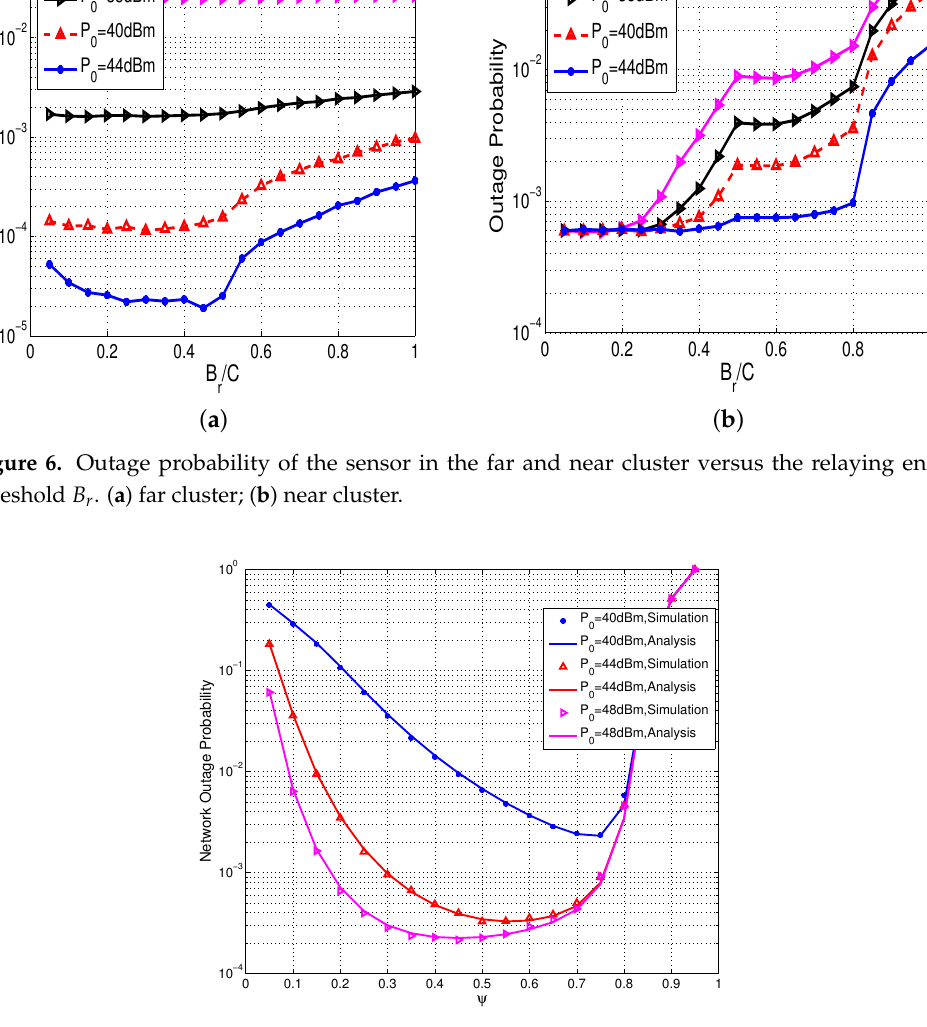
Figure 7. Network outage probability versus the time ratio ψ